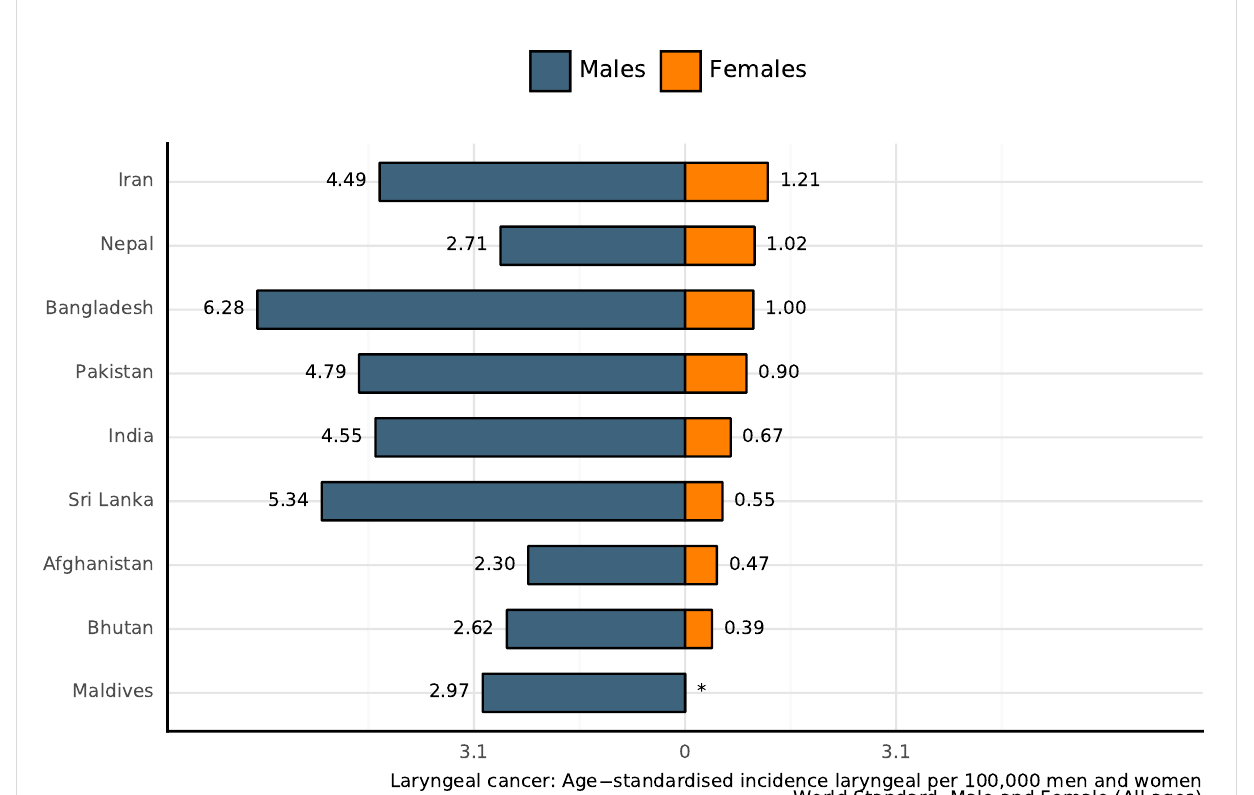
3.1 0 3.1 Laryngeal cancer: Age standardised incidence laryngeal per 100,000 men and women World Standard. Male and Female